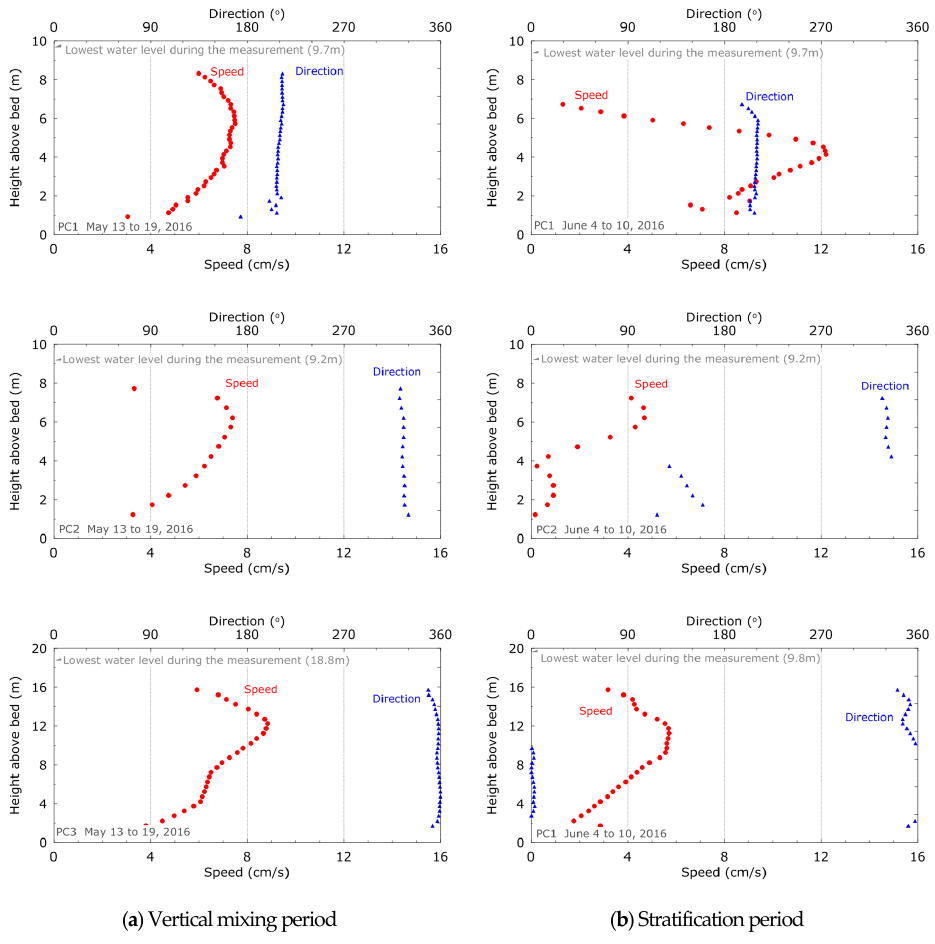
Figure 5. Profiles of the residual current for each station and period.